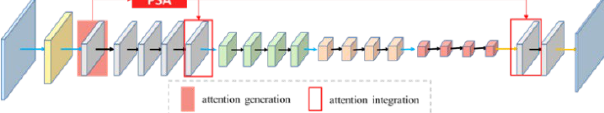
Figure 9. The workflow of PSA module applied in